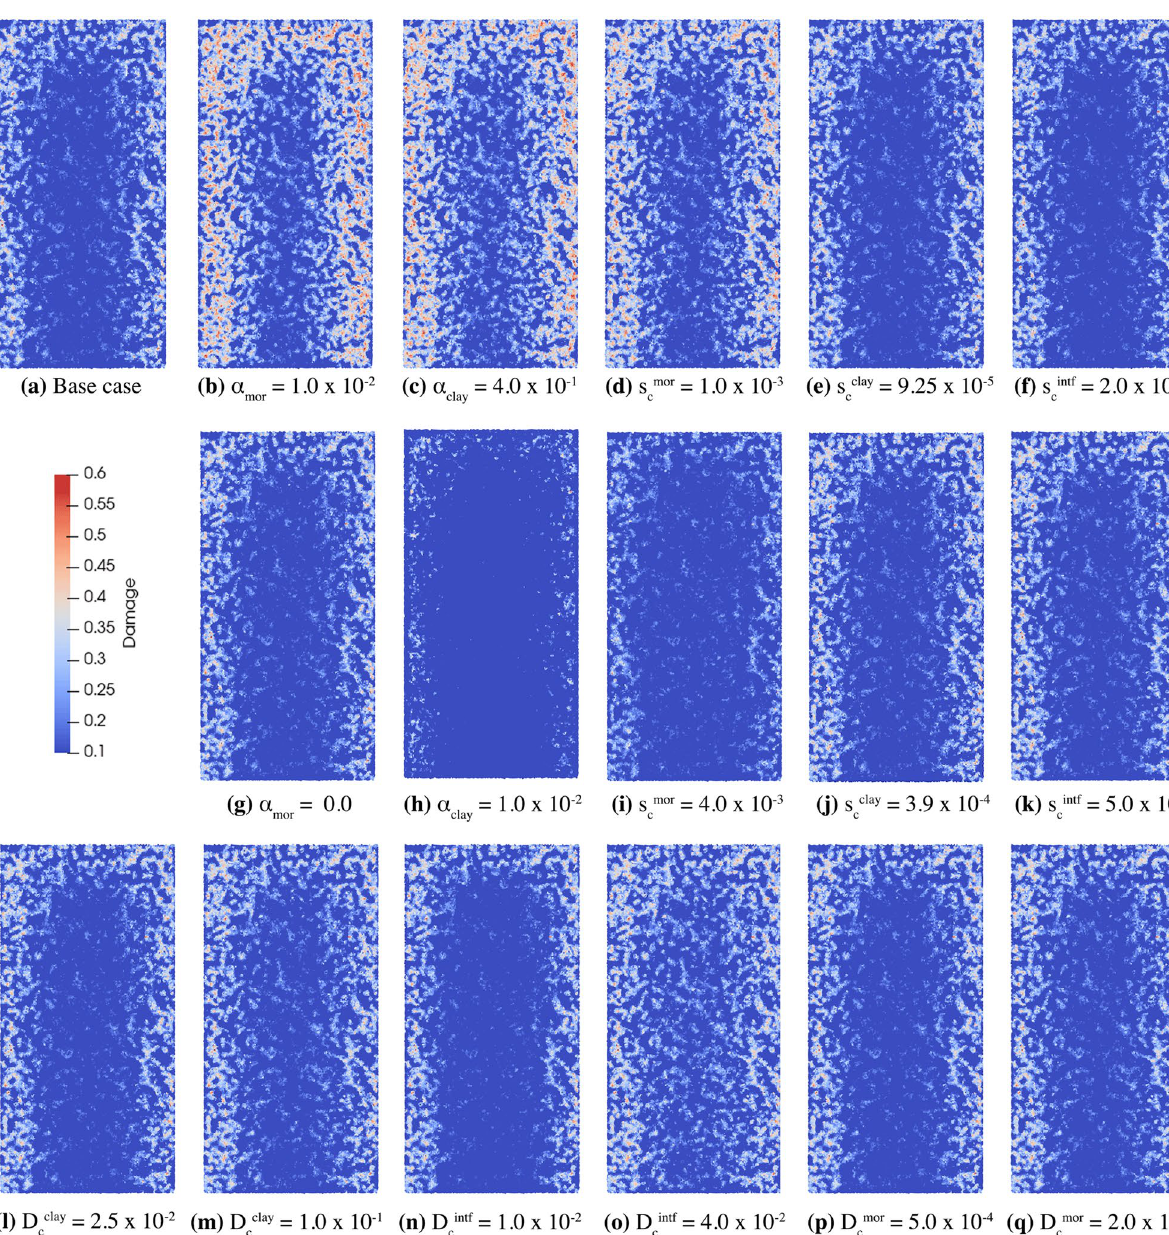
Figure 7. The final crack patterns among mortar nodes for the CB structure parameter study, viewed as a cross section of the model structure. The base case, ( a ), corresponds to parameters shown in Table S8 and “Methods” section: “Boundary conditions”. The remaining images correspond to the same parameters with a single parameter modified as specified in the associated caption. The parameters α , s c , and D c describe the shrinkage, critical stretch, and diffusivity and their corresponding superscripts/subscripts denote the material: mortar (mor), clay, or interface (intf). The most significant changes in the distribution of damage were observed when altering the shrinkage α (particularly for clay) and the critical stretch parameter s c . The diffusivity, was observed to have little impact on the damage